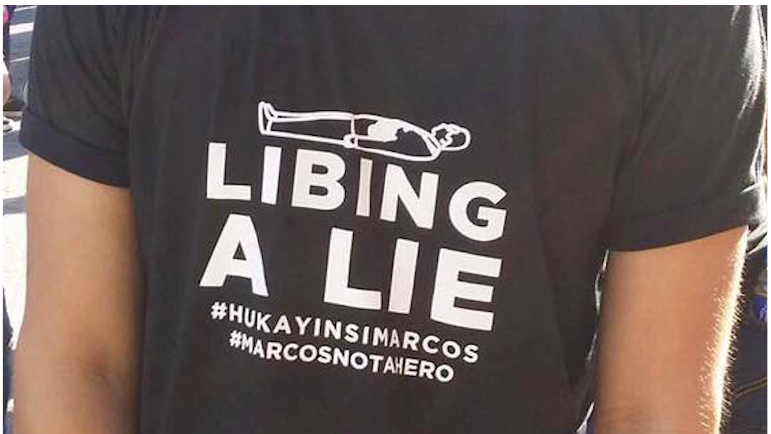
Figure 7. Bilingual English protest sign. ‘Libing’, which means ‘bury’, is a pun of the phrase ‘living a lie’ which references the life of Marcos, who had been accused of having war medals he didn’t earn. “Hukayin si Marcos” is Tagalog for “Unbury Marcos” (From Kevin Mandrilla Facebook page).